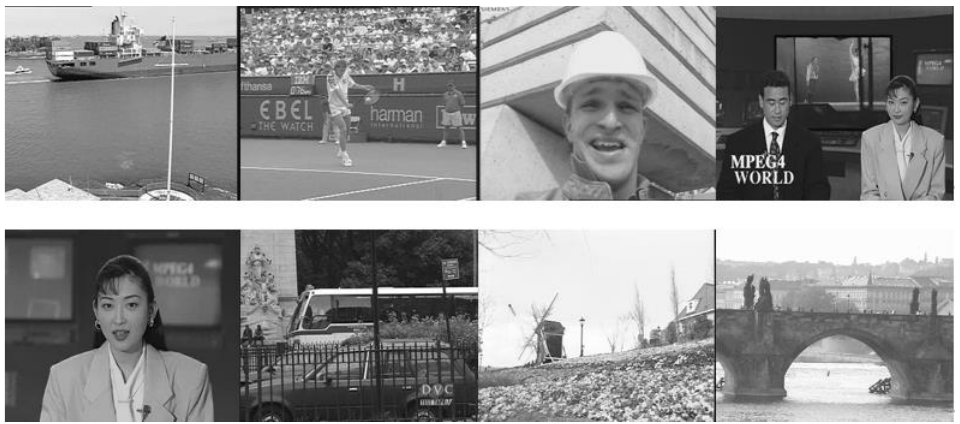
Figure 12. 20th frame of each labeled decrypted video.